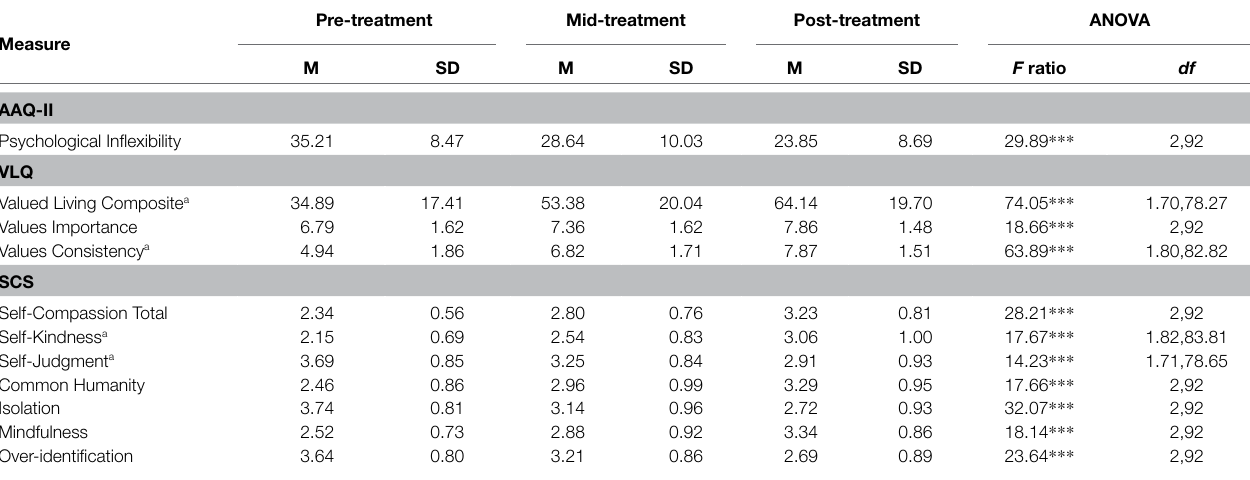
TABLE 2 | Repeated measures ANOVA for psychological inflexibility, values-based action, and self-compassion.